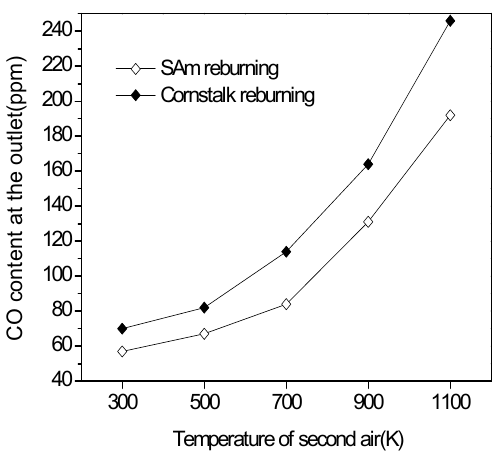
Figure 13. CO content at the outlet under different temperatures of the secondary